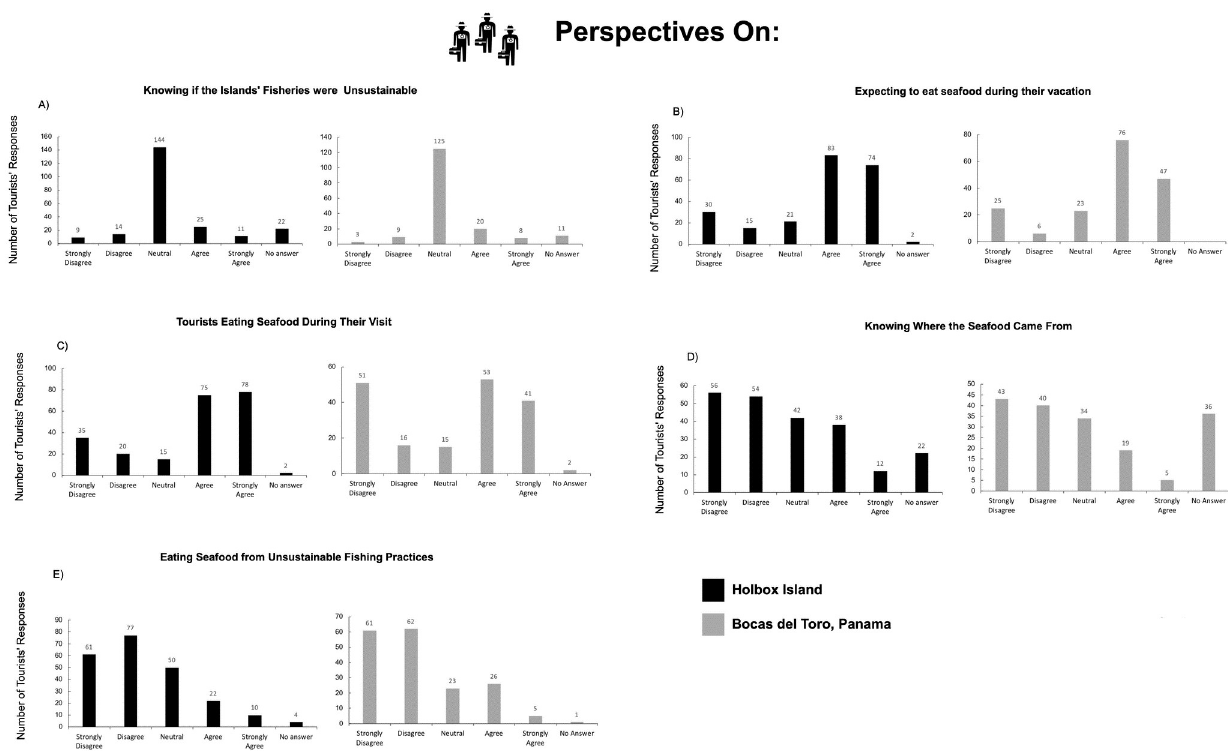
Fig 7. Bar charts depict tourists’ responses to the field survey. (A) Holbox fisheries; (B) tourists’ expectations of consuming and eating seafood (C); (D) tourists who knew where the seafood came from; (E) tourists who would eat unsustainable seafood.